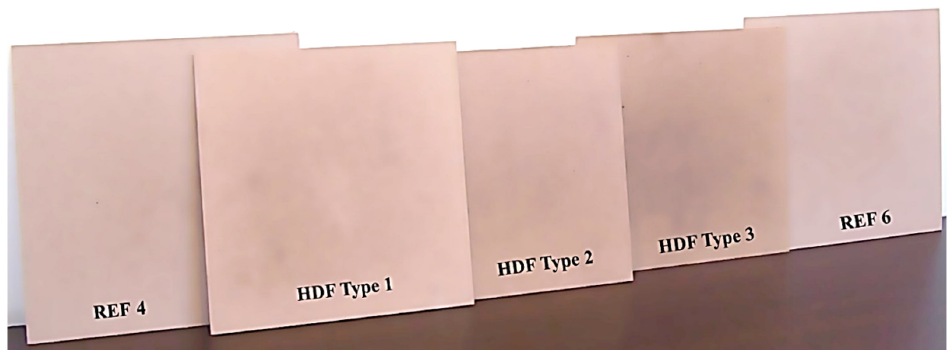
Figure 1. HDF panels from industrial hardwood fibers bonded with UF resin and ALS (910 kg·m − 3 target density, 6 mm thickness, and three addition levels (4%, 6%, and 8%) of ALS) and control HDF panels (REF 4 and REF 6) bonded with UF resin.